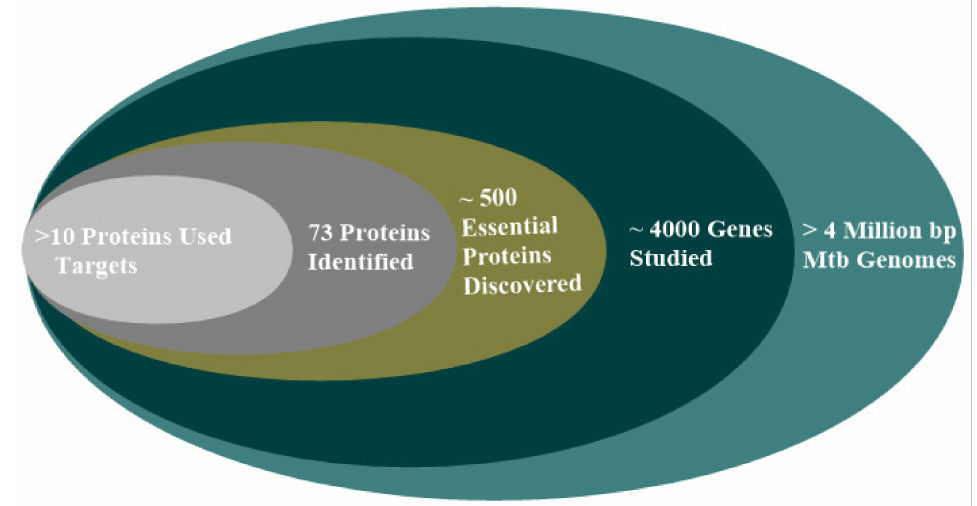
Figure 7. A representation of the genome of Mtb genes, essential proteins, and the number of proteins currently in use as targets for drug discovery, redrawn from the literature